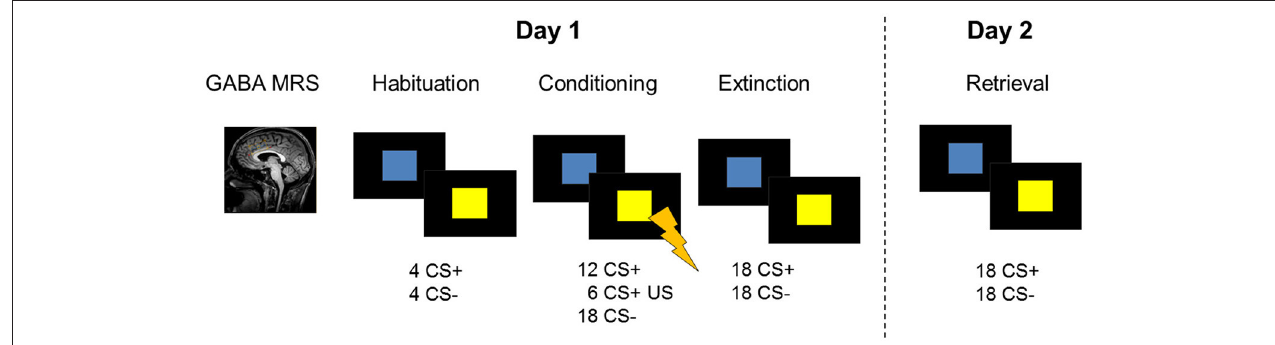
FIGURE 1 | Description of the 2-day study design including GABA MRS of the dACC and a fear conditioning and extinction paradigm during fMRI on experimental day 1. On the following day, participants were tested for memory retrieval during fMRI. Skin conductance responses were recorded as a psychophysiological measure of on both